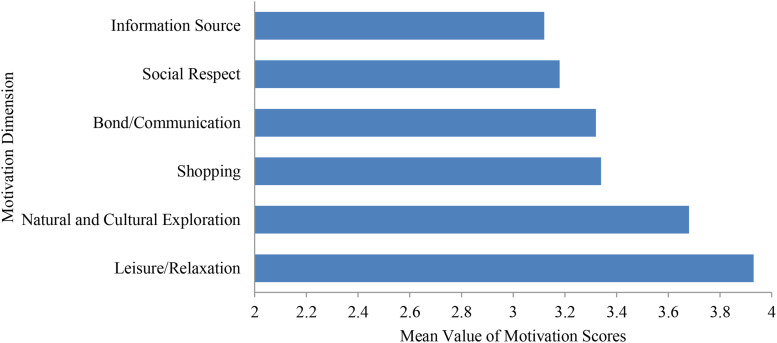
Comparison of cruise motivation dimensions.